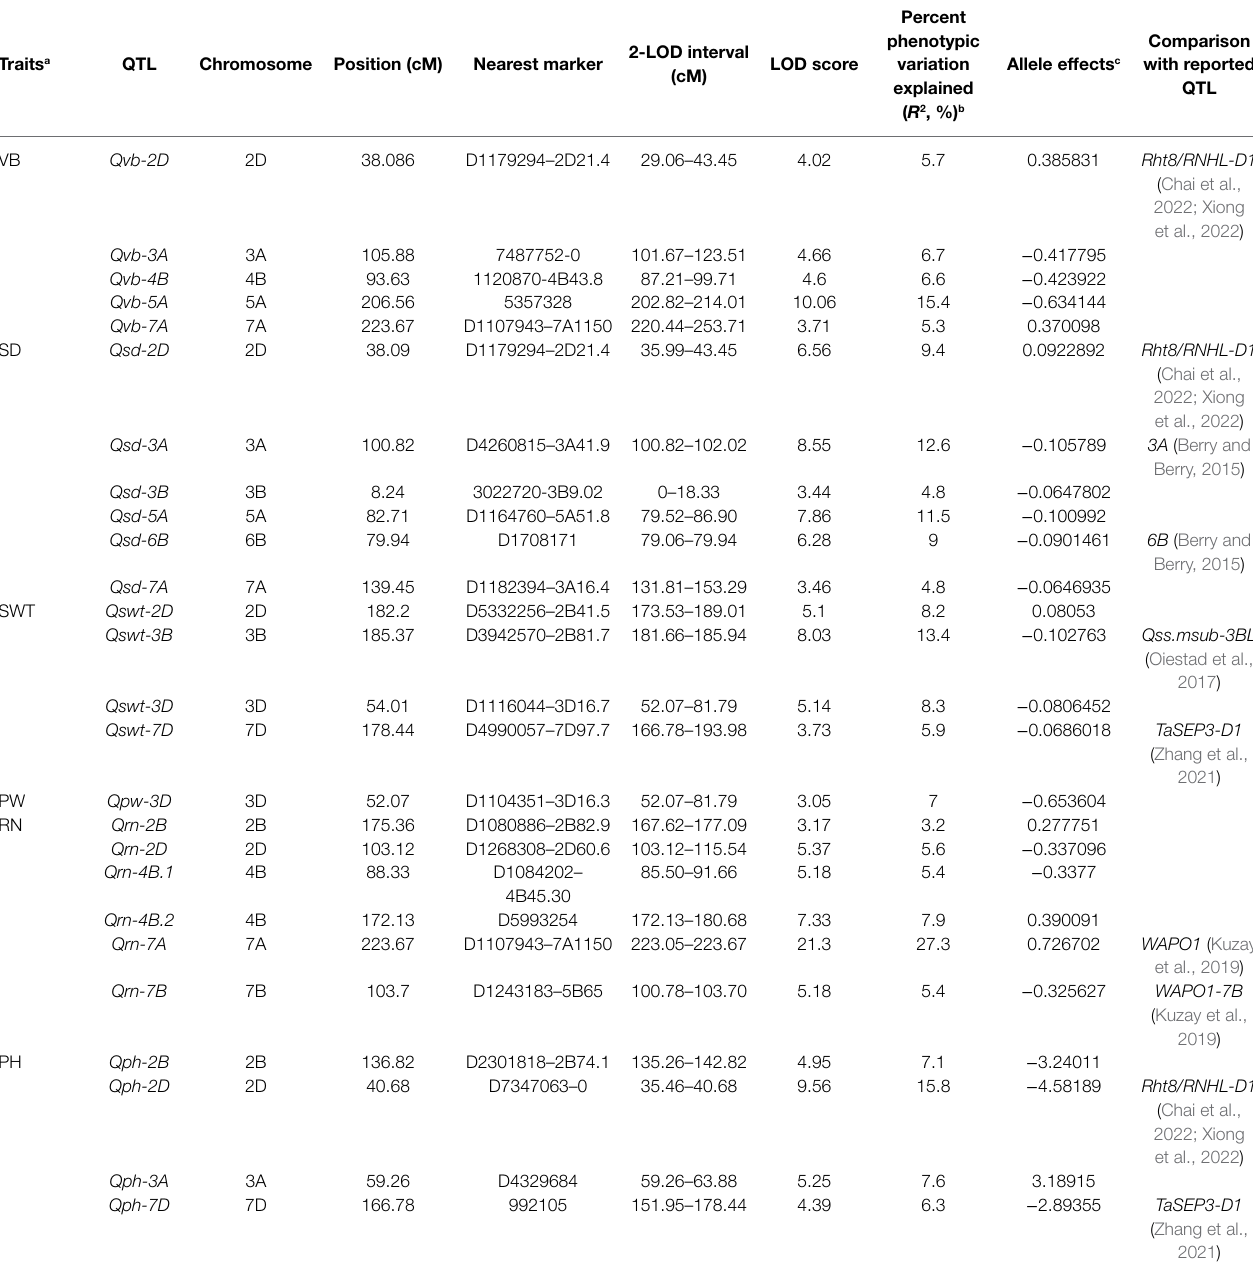
TABLE 3 | QTL for stem- and yield-related